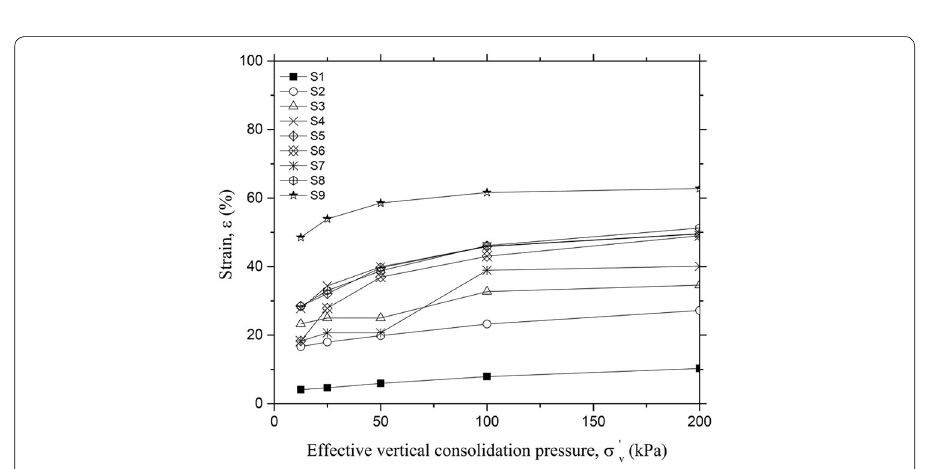
Fig. 7 Stress–strain relationship for the homogeneous kaolin–bentonite